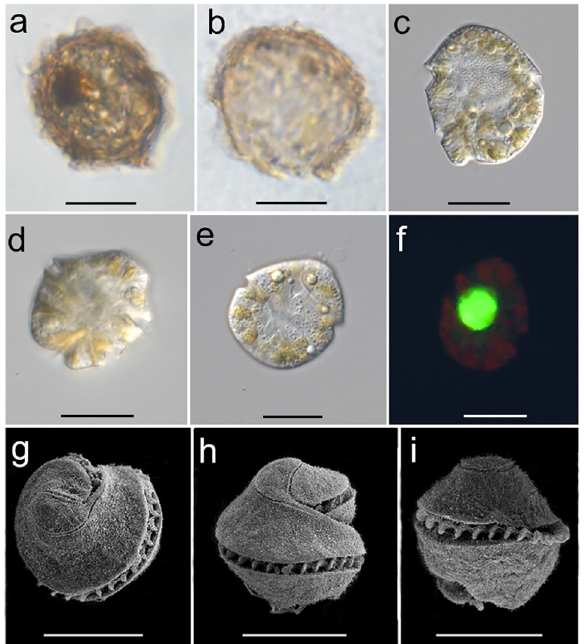
Figure 1. Light microscopic micrographs of the Pseudocochlodinium profundisulcus resting cyst ( a ), empty cyst ( b ), and vegetative cells ( c – f ); scanning electron microscopic micrographs ( g – i ) of the vegetative cells; Scale bars = 20 μm.